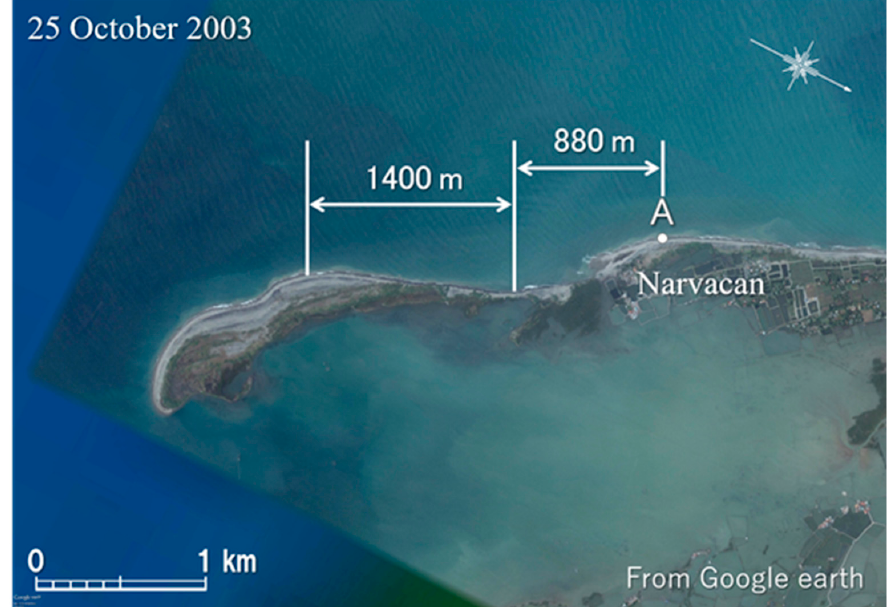
Figure 21. Satellite image around the sand spit at Santo Tomas (25 October 2003).